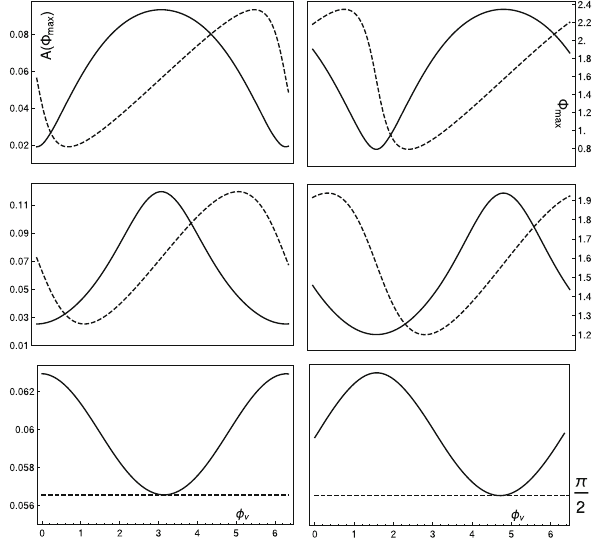
Fig. 6 Dependence of A (Φ max ) on φ ν (solid line) and Φ max on φ ν (dashed line), for θ ν = π/ 2, E ν = 1 MeV . TRSC: upper left plot for | = 0 . 2 ,θ = 0; middle left plot the case of V − A and S R when | c R S , R S | = 0 . 2 ,θ = 0;lower forthecombinationof V − A with T R when | c R T , R T | = 0 . 2 ,θ = 0. left plot for the case of V − A with P R when | c R P , R P TRSV: upper right plot for the scenario with V − A and S R when | c R | = 0 . 2 ,θ = π/ 2; middle right plot for the case of V − A and S , R S | = 0 . 2 ,θ = π/ 2; lower right plot for the combination T R when | c R T , R T | = 0 . 2 ,θ = π/ 2 V − A with P R when | c R P , R P